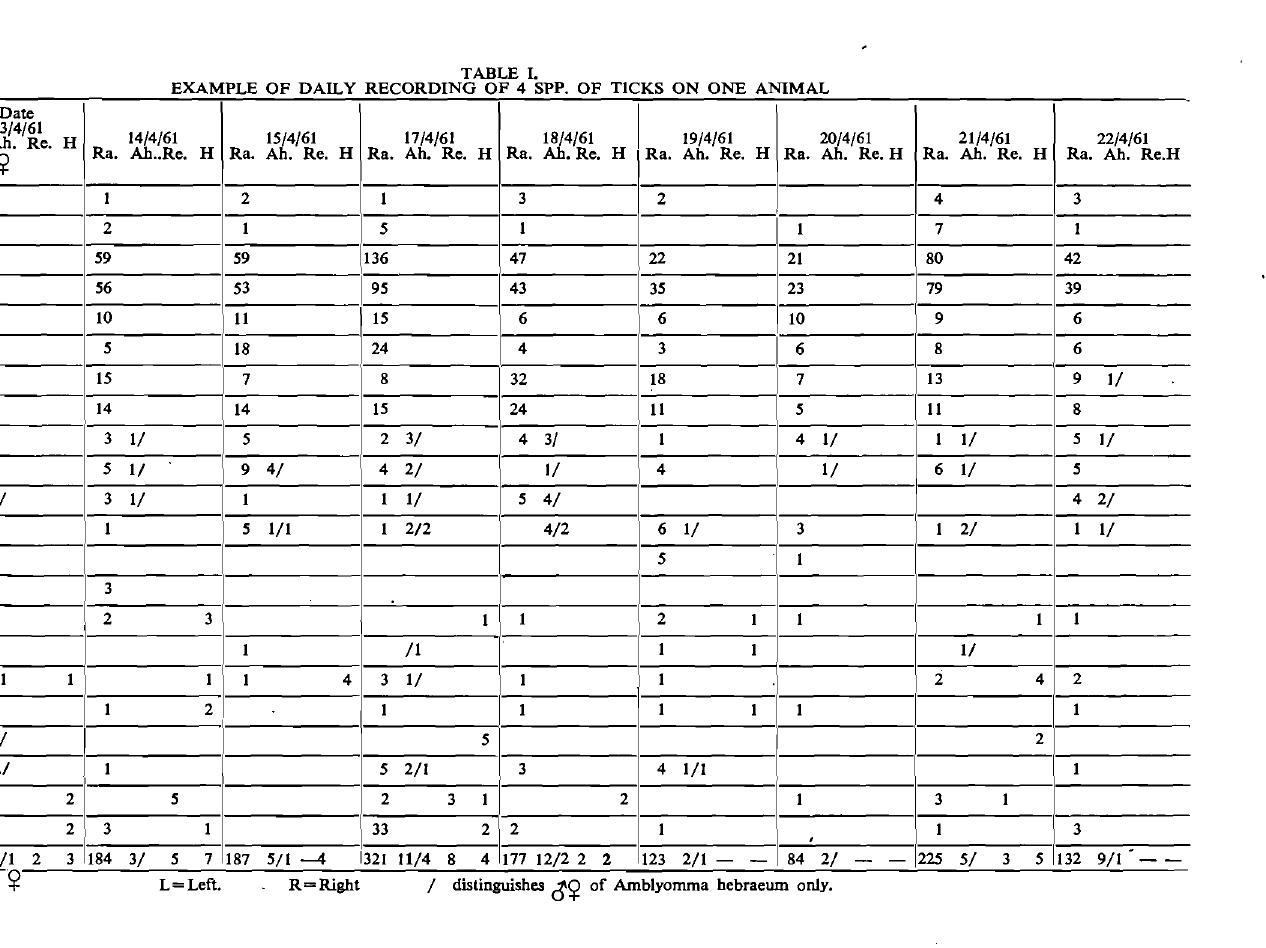
TABLE I. EXAMPLE OF DAILY RECORDING OF 4 SPP. OF TICKS ON ONE ANIMAL